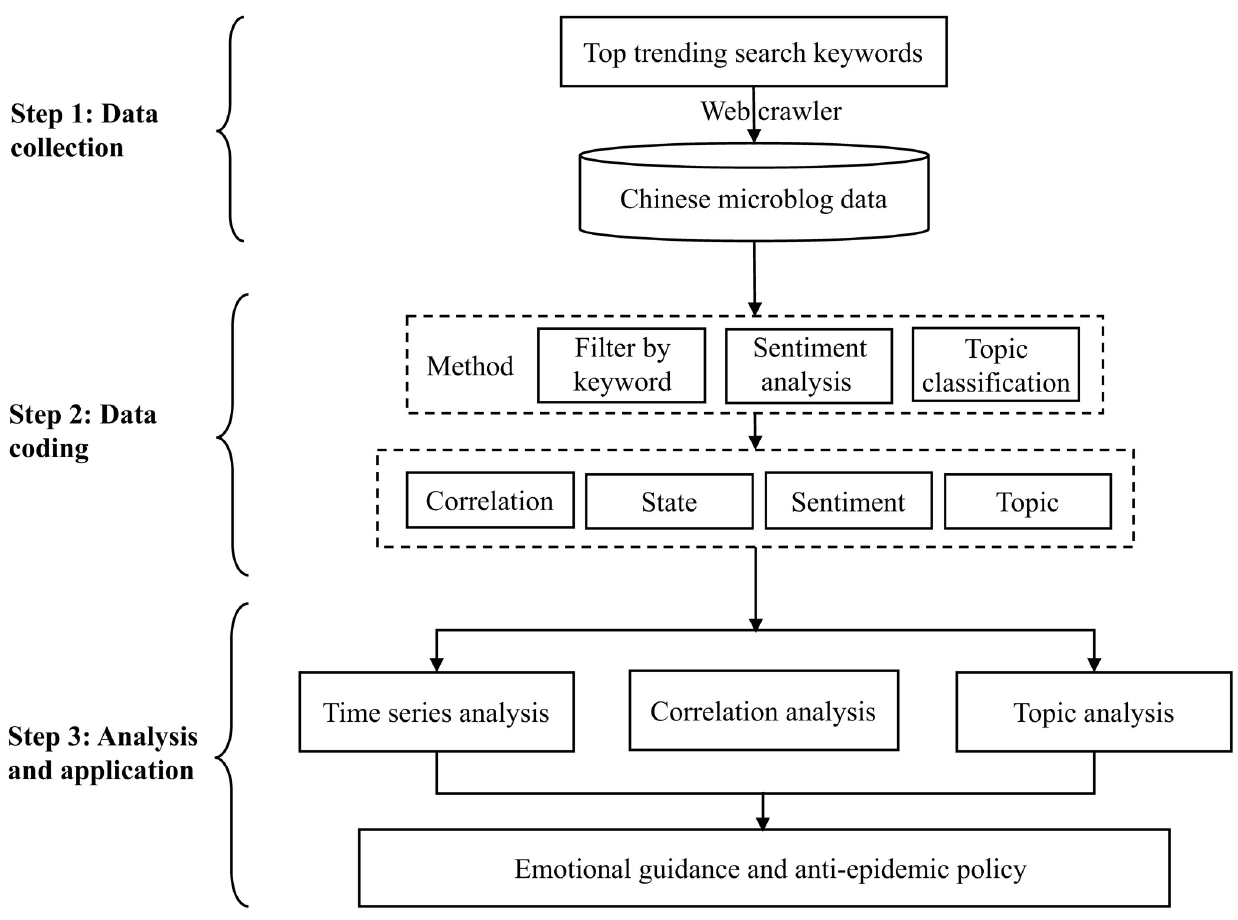
Fig 1. The framework of Weibo public sentiment